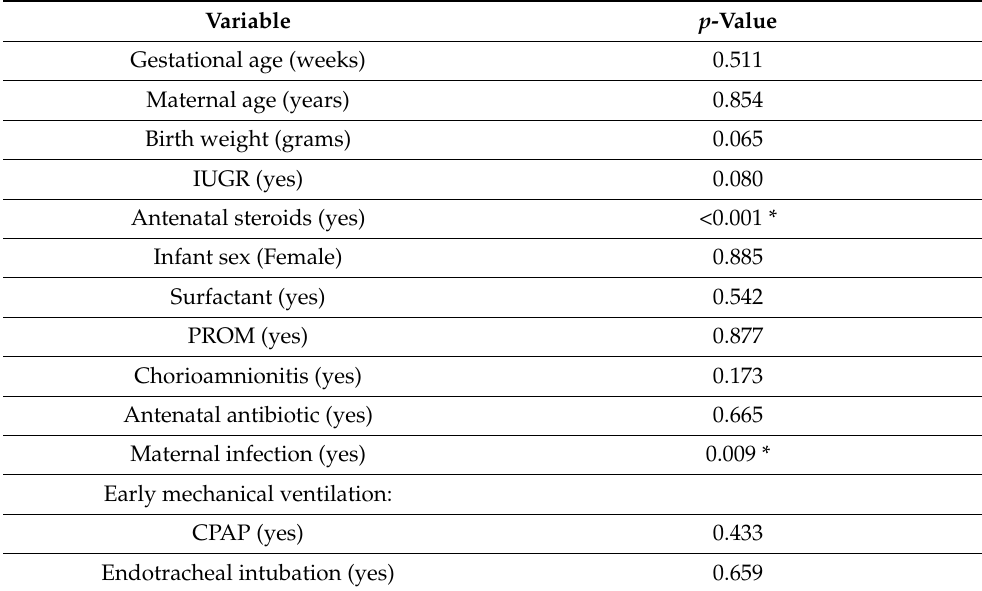
Table A1. Statistical test results for baseline clinical characteristics in Control and NEC groups.